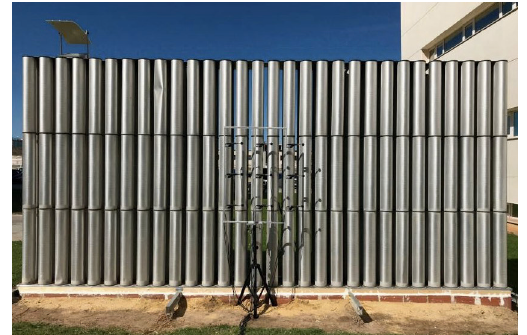
Figure 2. Noise barrier with air gaps (Dimitrijević et al.,